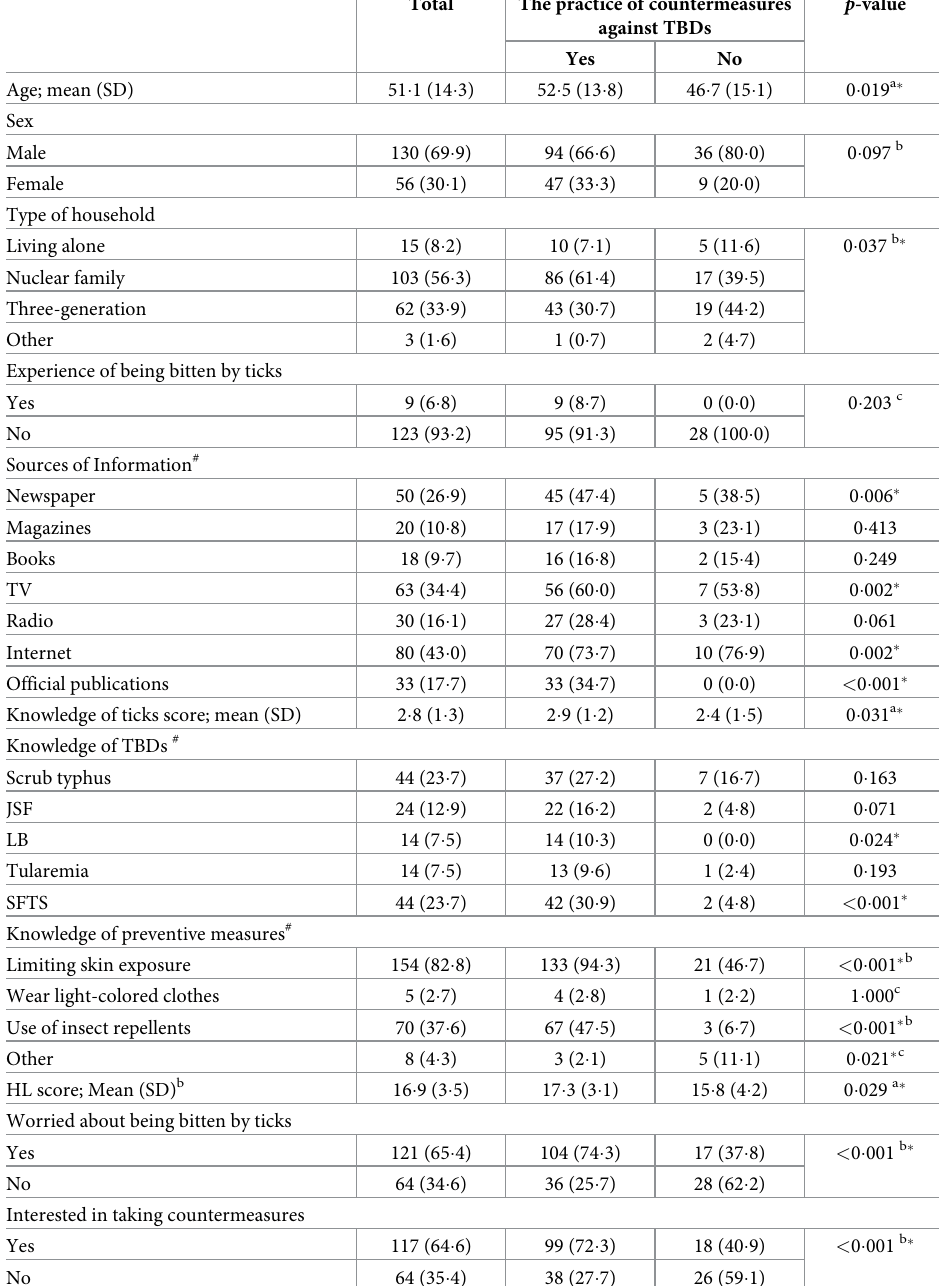
Table 4. Relationship of study variables with the practice of